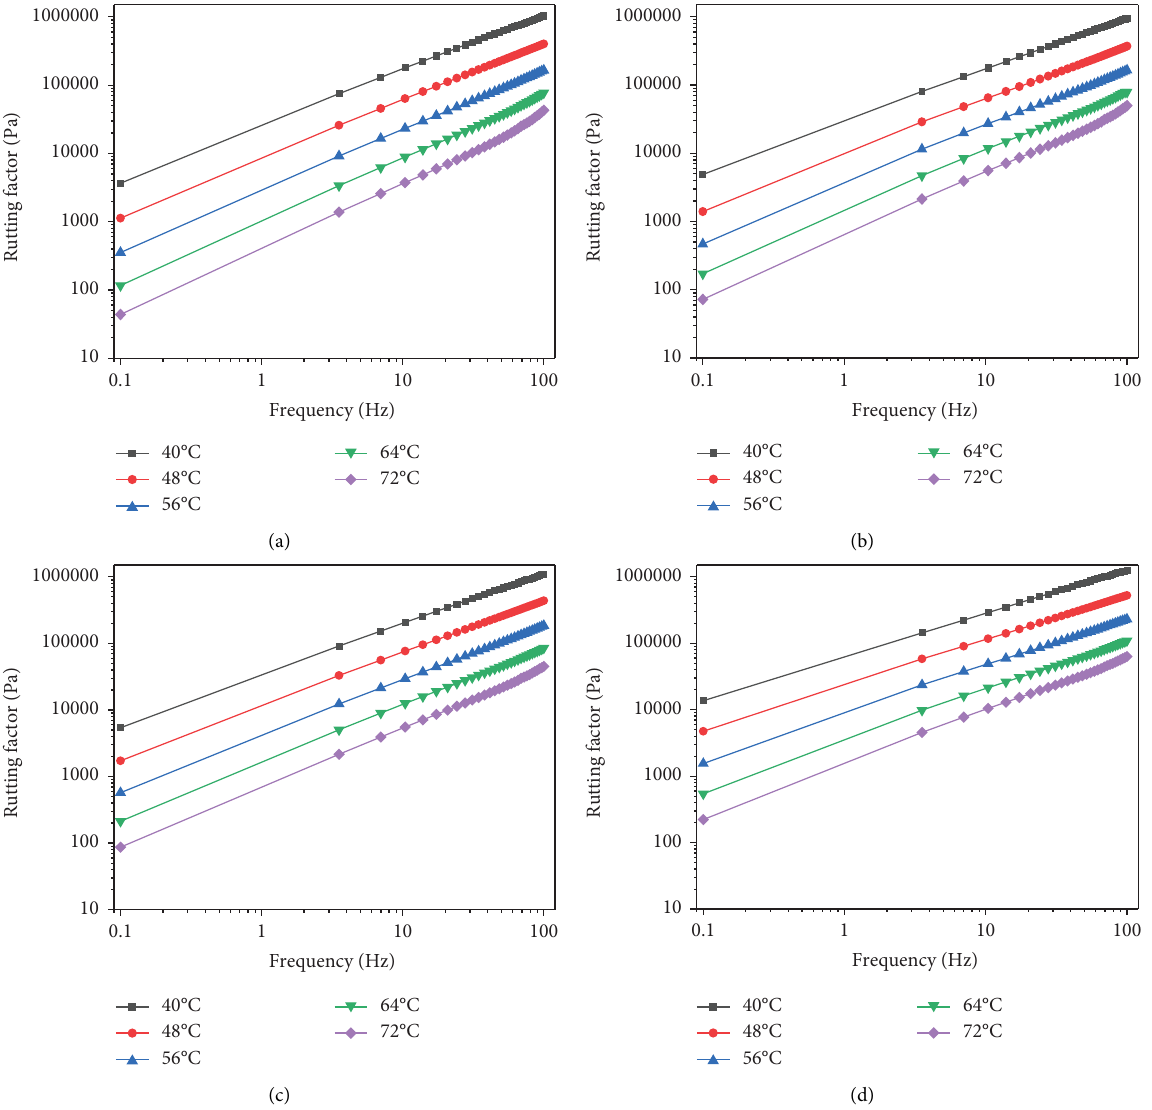
Figure 9: Variation of rutting factor with frequency for four types of emulsifed asphalt. (a) Base emulsifed asphalt. (b) 1.5% SBS modifed emulsifed asphalt. (c) 3% SBR modifed emulsifed asphalt. (d) SBS/SBR modifed emulsifed